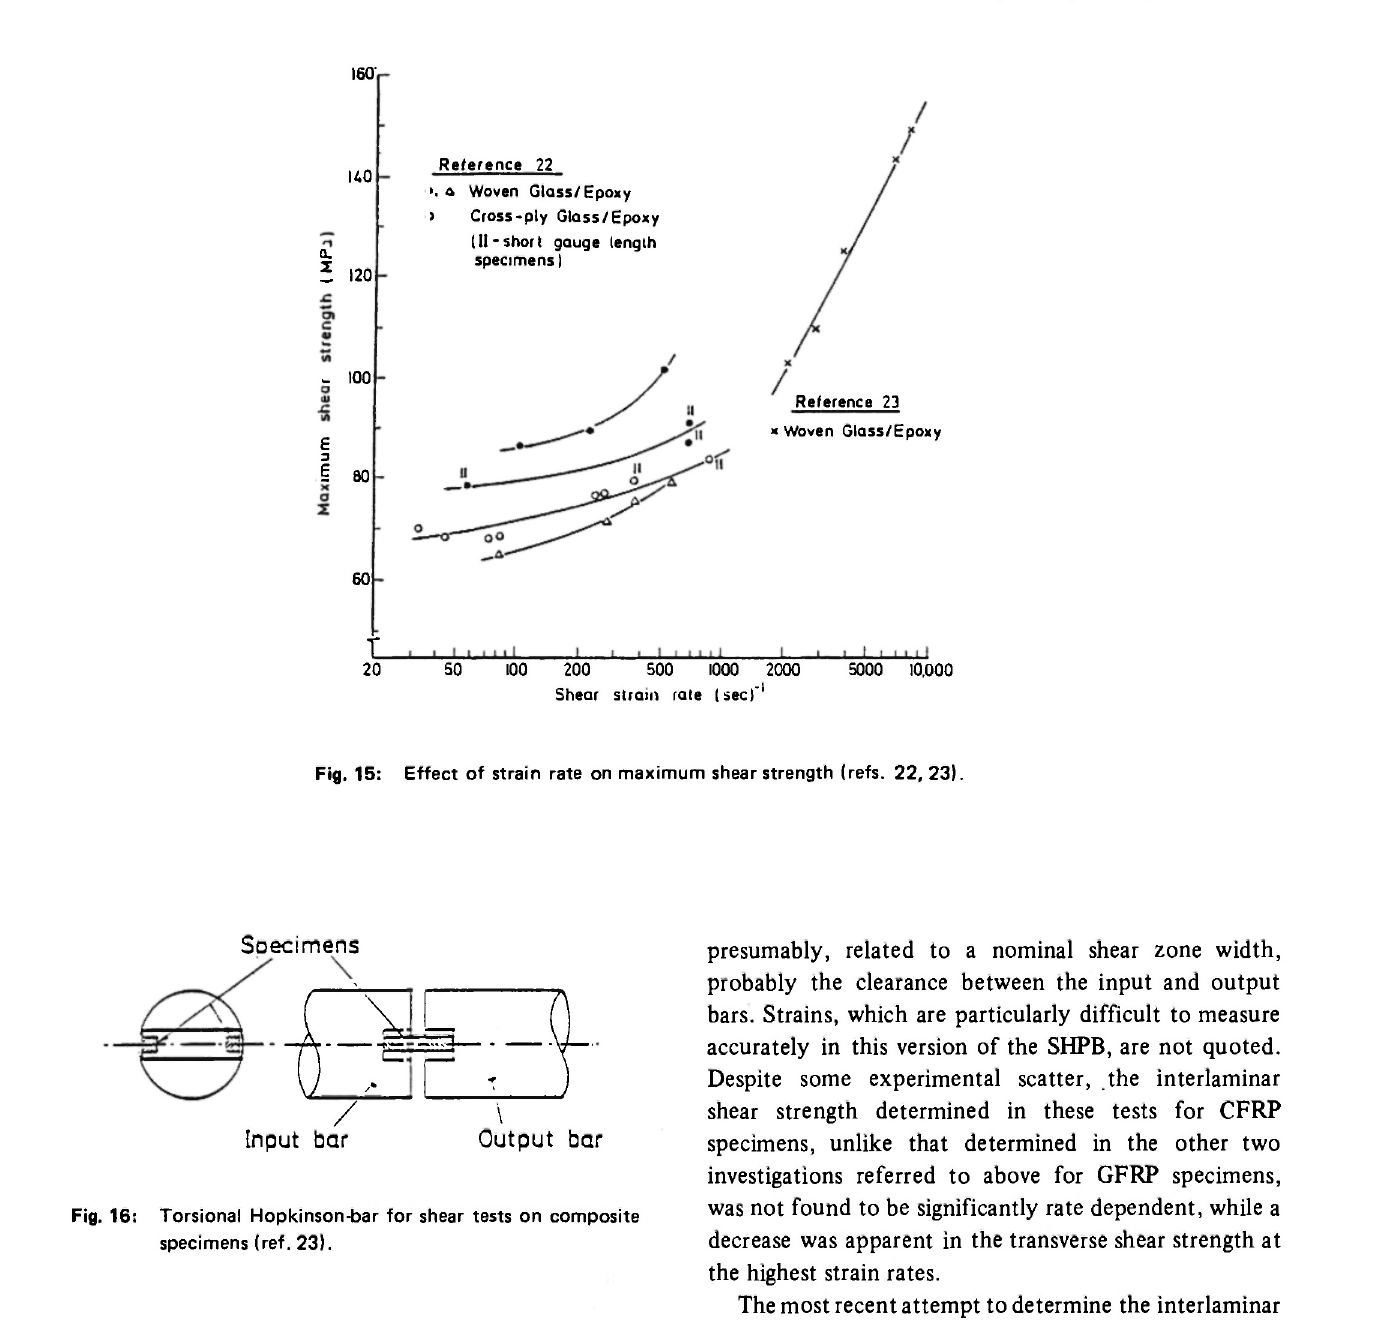
Fig. 16: Torsional Hopkinson-bar for shear tests on composite specimens (ref.